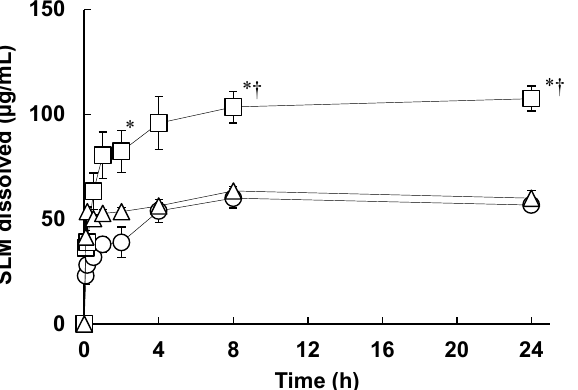
Figure 4. Dissolution behavior of silymarin/Hypromellose/erythritol nanoparticles (SLM/HPMC/Ery) NPs, SLM/HPMC/ α -cyclodextrin ( α -CyD) NPs, and SLM/HPMC/HP- β -CyD NPs. 〇 : SLM/HPMC/Ery NPs, △ : SLM/HPMC/ α -CyD NPs, □ : SLM/HPMC/HP- β -CyD NPs. The weight ratio of SLM/HPMC/stabilizers was 1/1/1. Data represent the mean ± SE of three experiments. * p < 0.05, compared to SLM/HPMC/Ery NPs. † p < 0.05, compared with SLM/HPMC/ α -CyD NPs.